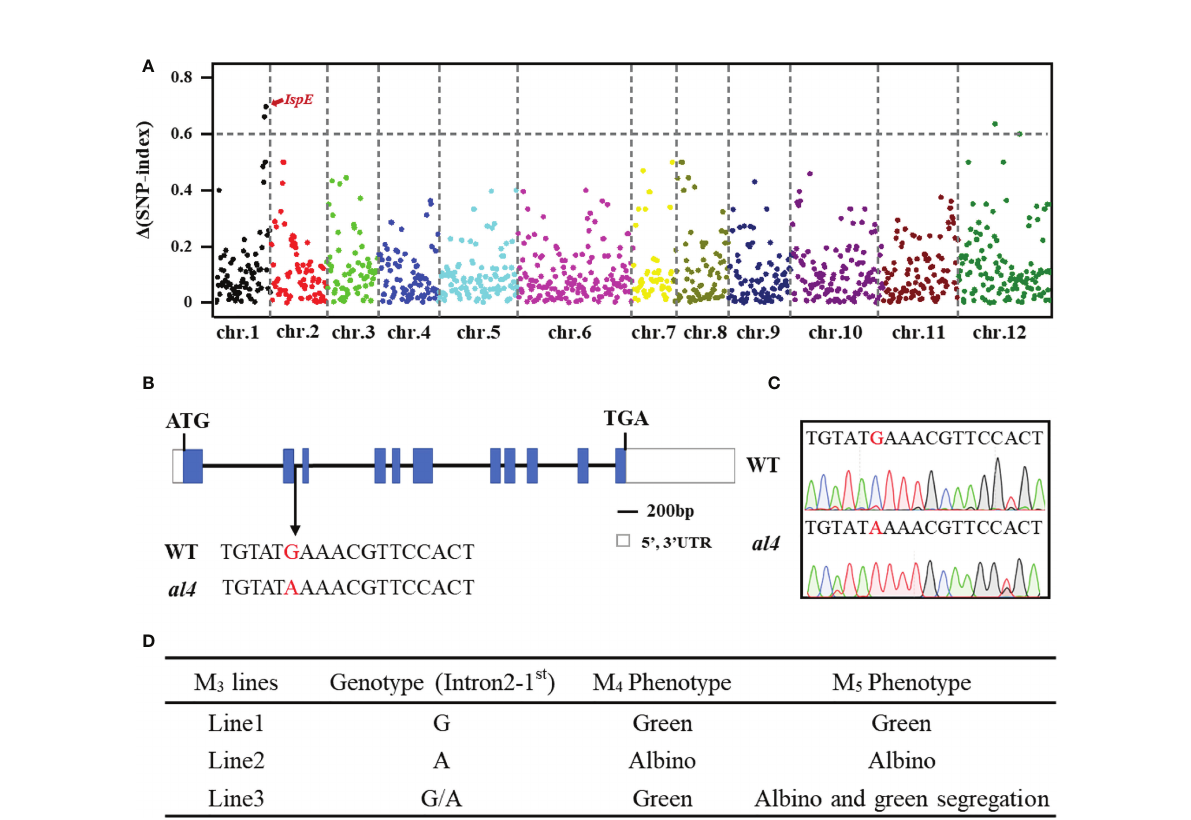
FIGURE 2 MutMap+ identi fi es the causal mutation of the al4 early-stage lethality phenotype. (A) D SNP-index plot of the whole genome generated by MutMap+ analysis. (B) Schematic diagram of al4 and point mutations between the WT and al4 mutant. Blue boxes represent exons and black lines represent introns. (C) Genomic regions spanning the mutation site of OsIspE were ampli fi ed and sequenced. (D) Segregation veri fi cation in different EMS